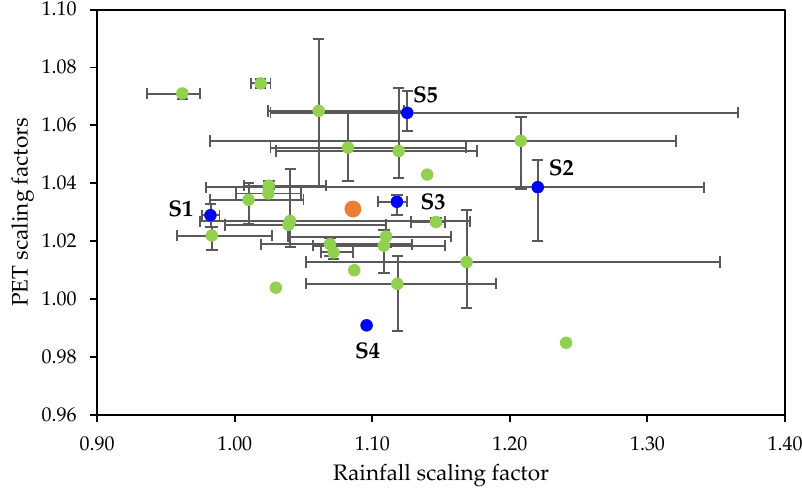
Figure 5. Method of selecting best GCMs for five scenarios (S1 to S5). Green, blue and orange dots represent 28 GCMs, five selected GCMs for S1 to S5 and average of 28 GCMs respectively. The error bar shows the spatial variability between six grids.